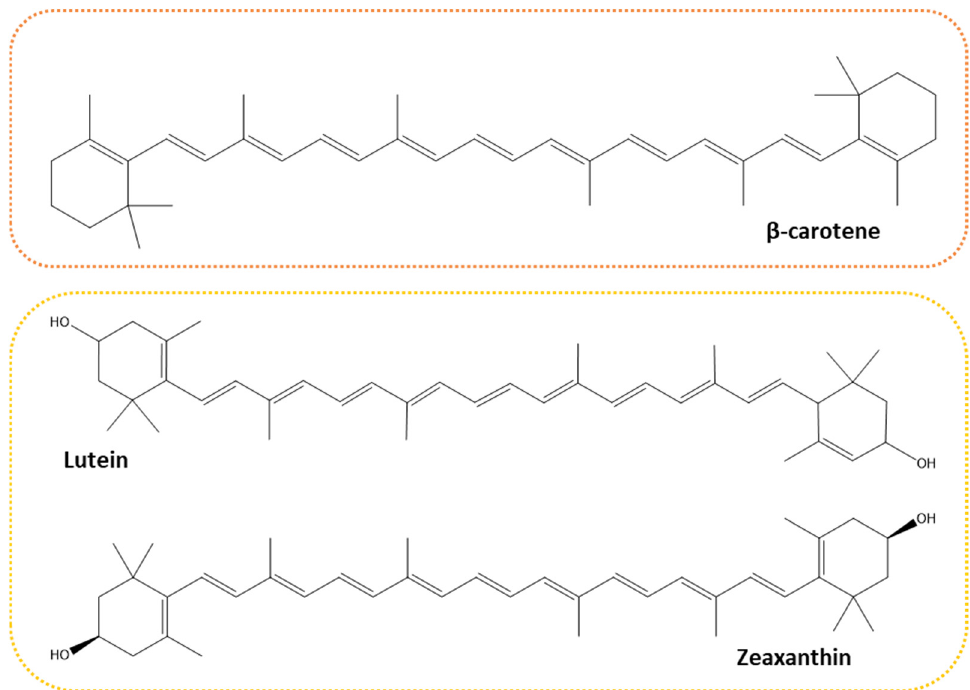
Figure 3. Example of commonly occurring carotenoids in algae. Carotene in the orange outline, xanthophylls—in the yellow outline.